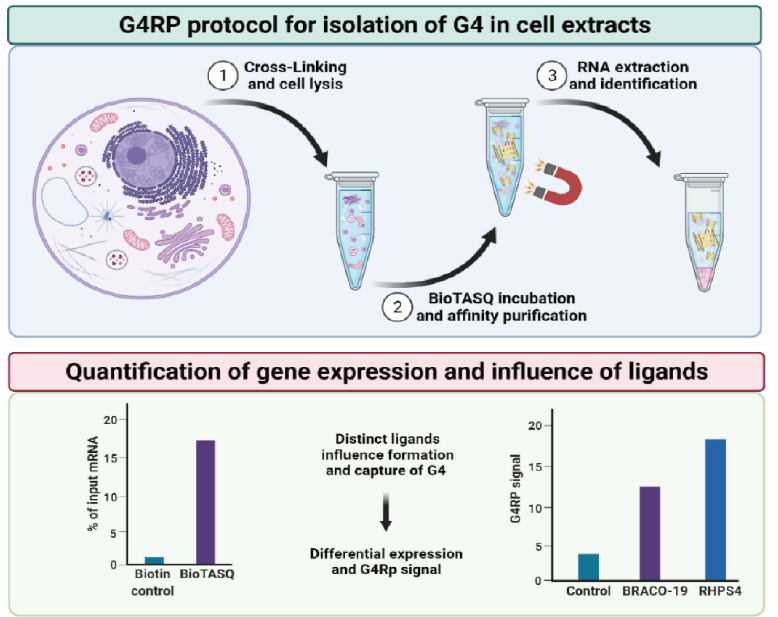
Figure 3. Illustration of G4RP method protocol for isolation of G4 targets from human cell extracts and the influence of the ligands in gene expression. Adapted from ref. [25]. Copyright (2018), with permission from Springer Nature.